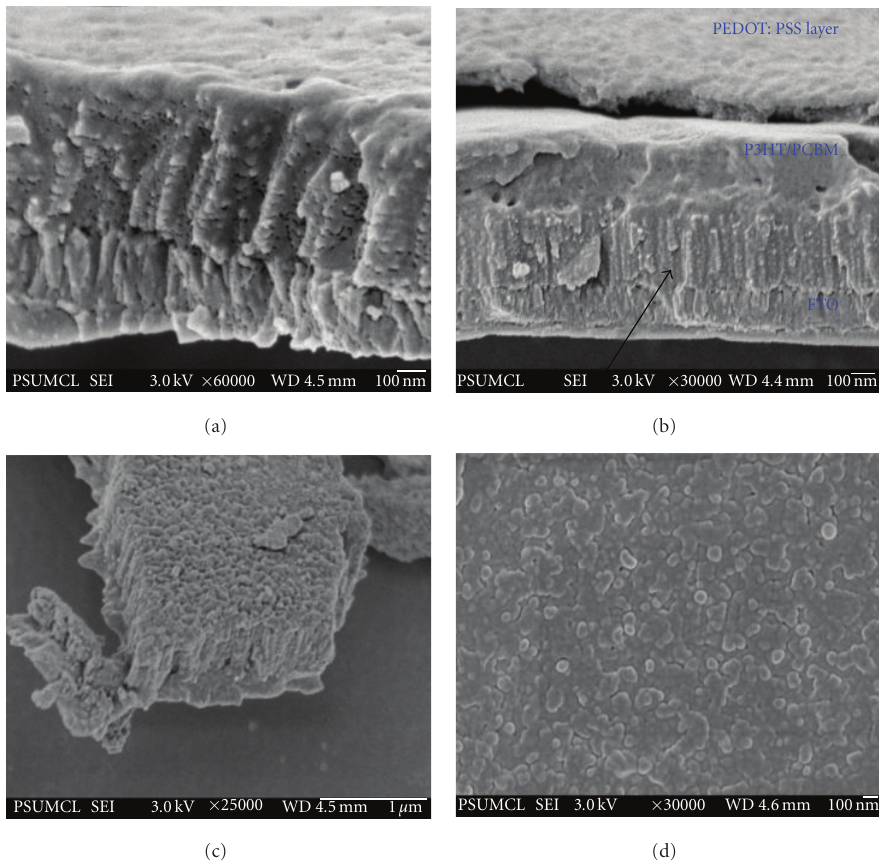
Figure 5: FESEM cross-sectional view of (a) P3HT/PCBM blend-filled nanotubes; (b) full device, with arrow denoting layer of P3HT/PCBM blend-filled nanotubes, with PEDOT:PSS layer on top. (c) FESEM cross-sectional view, of mechanically fractured sample, showing polymer blend decorated nanotubes with top unblocked. (d) Top view of PEDOT:PSS-coated full device. Reprinted with permission from